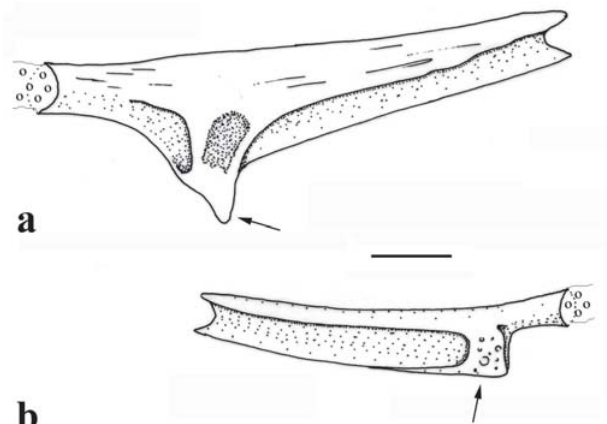
Fig. 27. Dorsal view of third epibranchial of Lamontichthys filamentosus (LACM 41741-9, 119.4 mm SL) (right side) (a) and Harttia loricariformis (MZUSP 66187, 67.7 mm SL) (left side) (b). Arrow points to posterior process of third epibranchial. Scale bar = 0.5